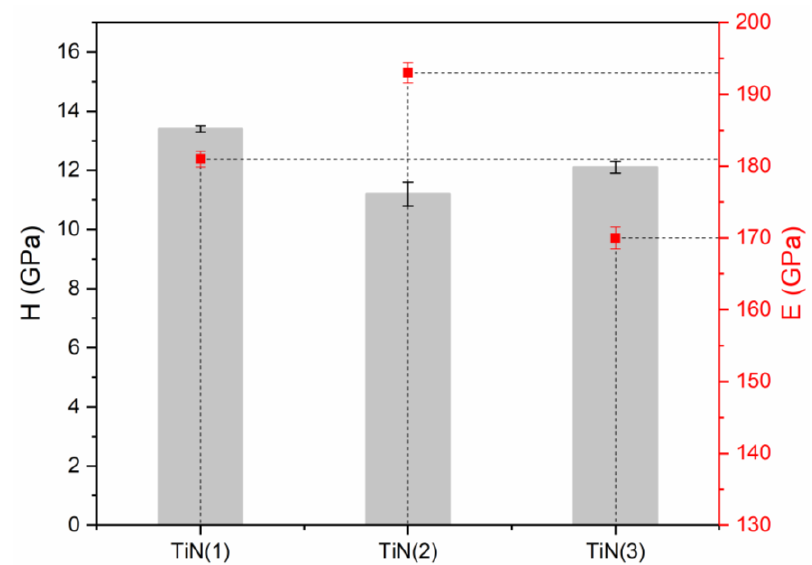
Figure 10. Results of nanoindentation of TiN coatings obtained by the APS method.